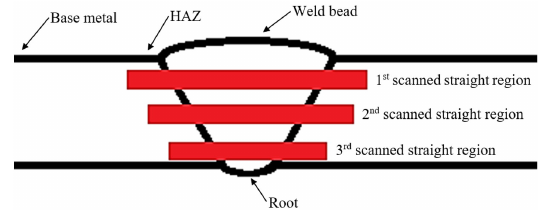
Figure 2. Schematics of the sites where the qualitative analysis of phases present in the welded joints was